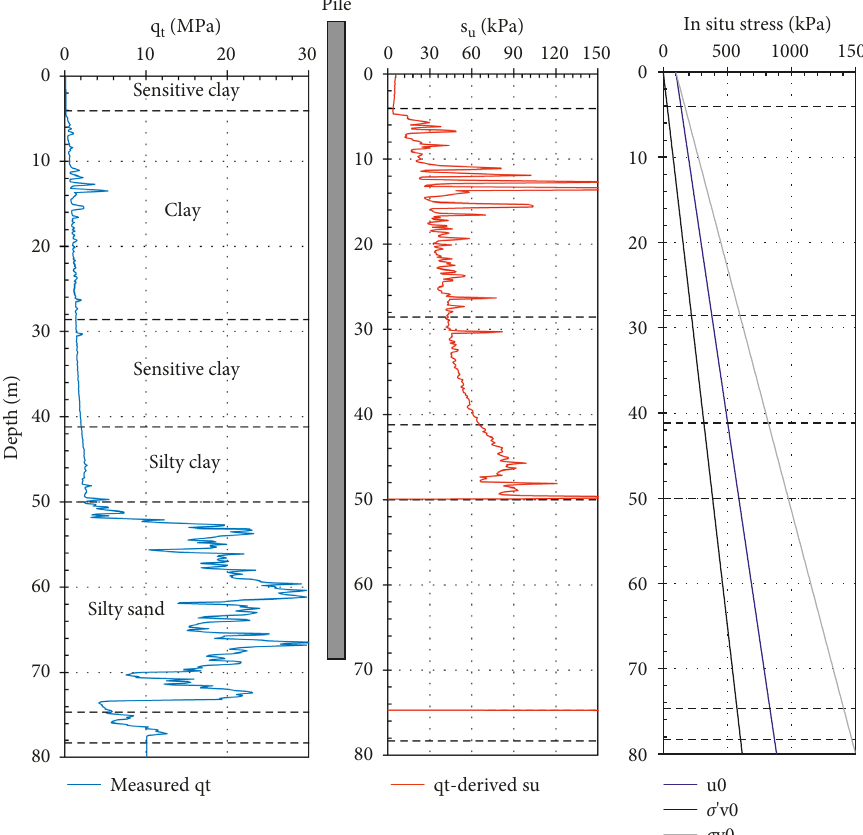
Figure 11: Profiles of cone tip resistance, undrained strength, and in situ